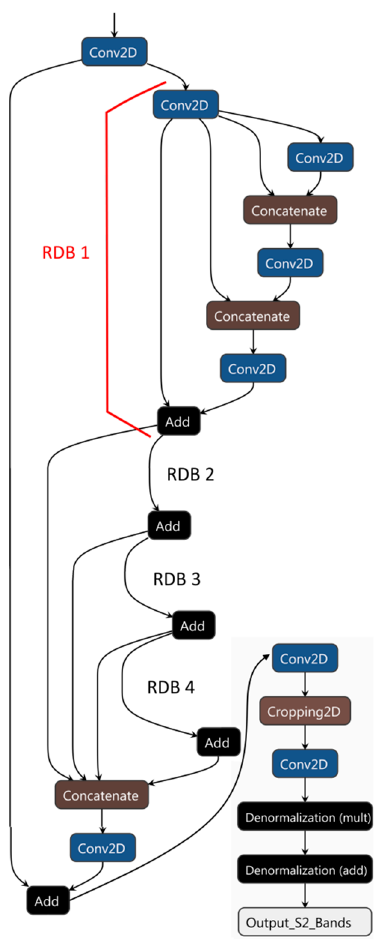
Figure 4. Neural network architecture: data transformation step of the two super ‐ resolution neural networks. PS, PlanetScope; S210, Sentinel ‐ 2 10 ‐ m data; S220, Sentinel ‐ 2 20 ‐ m data. See Table 2 for patch sizes and resolutions of input and output data.